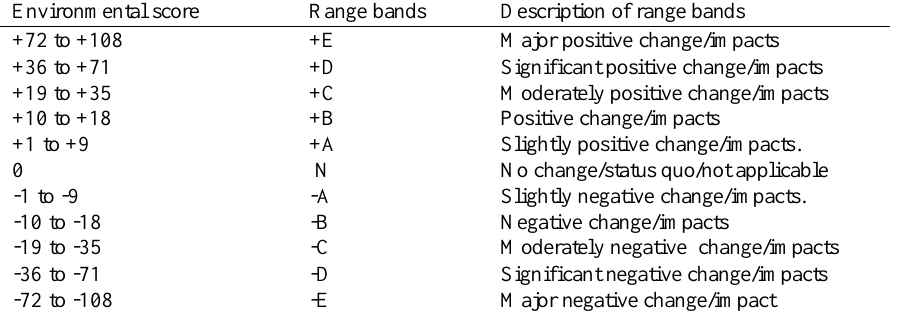
Table 2. Conversion of environmental scores to range bands (Pastakia 1998; Pastakia and Jensen,